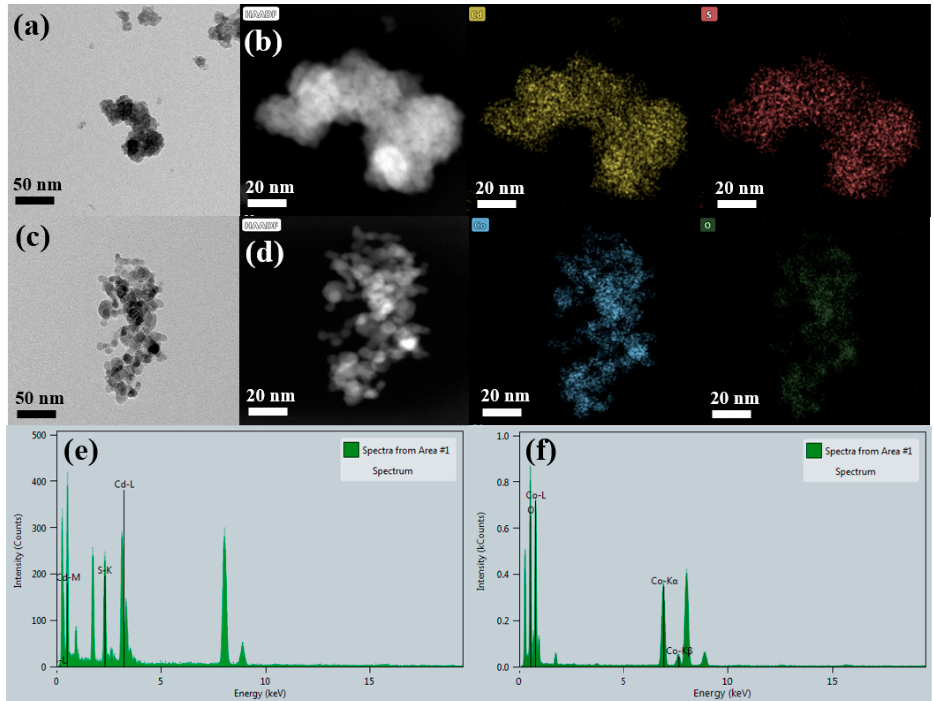
Figure 1. HRTEM images of ( a ) CdS and ( c ) Co 3 O 4 ; HAADF images with corresponding elemental mapping of ( b ) CdS and ( d ) Co 3 O 4 ; EDS spectrum of ( e ) CdS and ( f ) Co 3 O 4 . The phase verification of the as-synthesized samples was performed using X-ray dif- fraction (XRD) analysis. Figure 2a depicts the XRD pattern of CdS possessing dominant diffraction peaks at 26.45°, 44.1°, and 52.21° corresponding to (111), (220), and (311), as- cribed to the zinc blende (cubic) phase of CdS [41]. The remaining peak also matched well with the JCPDS card 75-1546 of cubic CdS. In contrast, the diffraction peaks at 19.11°, 31.23°, and 36.78° were stronger reflections indexed to the (111), (220), and (311) planes of the Co 3 O 4 crystal structure. All peaks for the Co 3 O 4 nanoparticles matched well with the